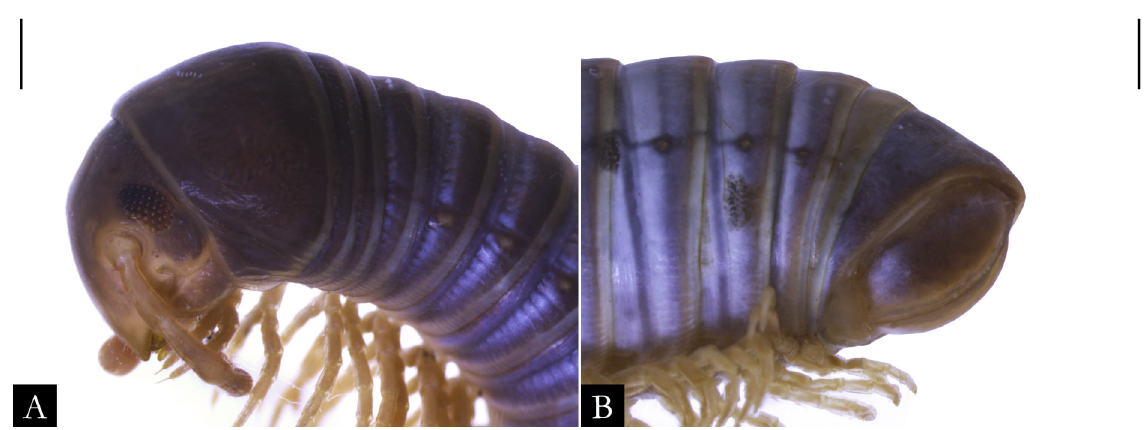
Fig. 70. Pseudonannolene halophila Schubart, 1949, ♀ (IBSP 1101), in lateral view. A . Anterior region. B . Posterior region. Scale bars = 0.5